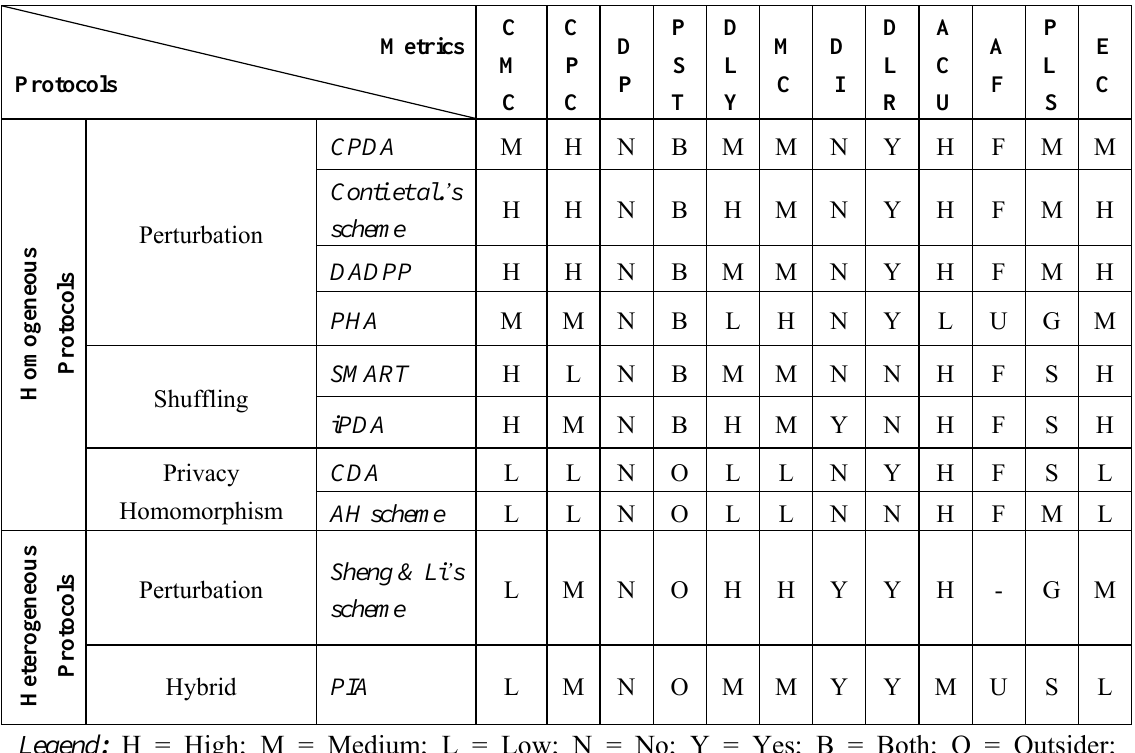
Table 1. Comparison result of PPDA protocols for